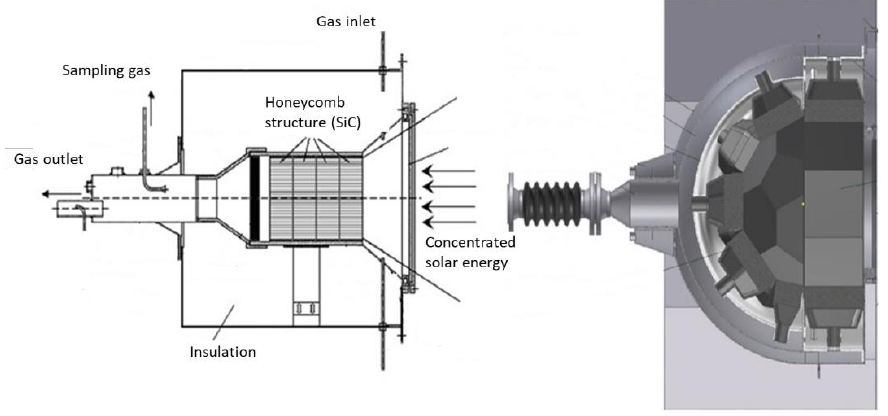
Figure 6. Schemes of monolithic solar reactors integrating a porous structure.